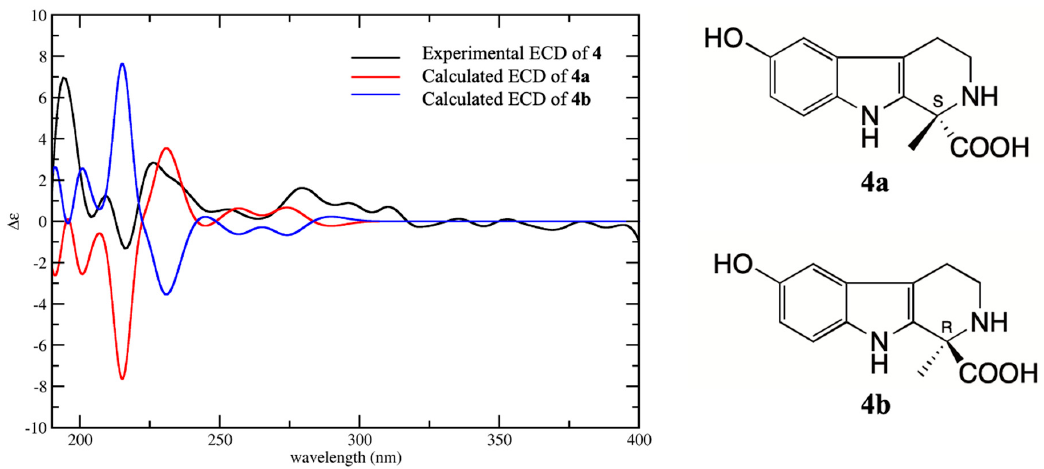
Figure 3. Experimental CD spectrum of 4 in H 2 O and the calculated ECD spectra of (1 S )-4 ( 4a ) and (1 R )-4 ( 4b ).